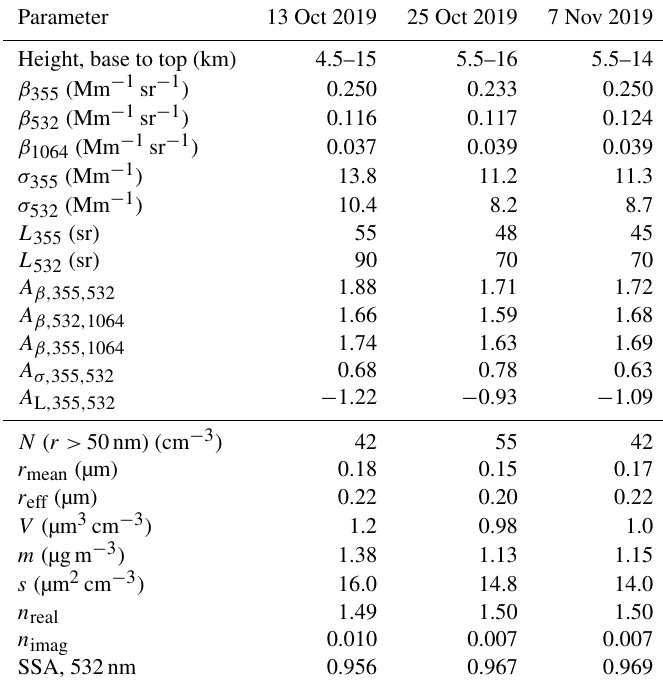
Table 4. Optical and microphysical properties of the polar wildfire smoke layer in the autumn of 2019. Layer mean values of the particle backscatter coefficient β , extinction coefficient σ , lidar ratio L , and backscatter-, extinction-, and lidar-ratio-related Ångström exponents A β , A σ , and A L , respectively, are given in the upper part. Indices indicate wavelength in nanometres and wavelength spectrum. The lower block contains the retrieved particle number concentration (particles with radius > 50nm), mean and effective particle radius ( r mean and r eff ), volume ( V ), mass ( m ), surface area ( s ) concentration, the real ( n real ) and imaginary part ( n imag ) of the refractive index, and single scattering albedo (SSA). Similar SSA values were obtained for all three wavelengths. Uncertainties are given in Table 1 and are ± 0.1 for n real , within an order of magnitude for n imag and of the order of ± 0.05 for